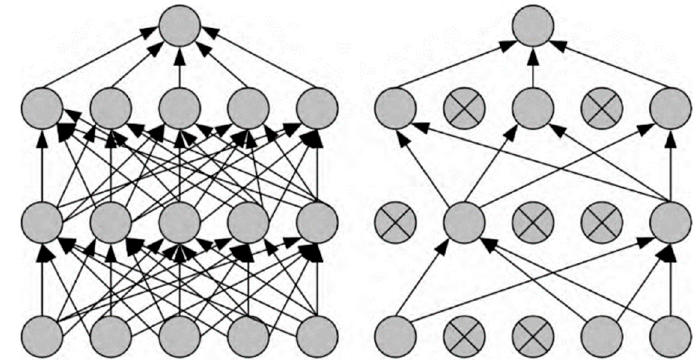
Figure 7. Neural network models before and after using Dropout.